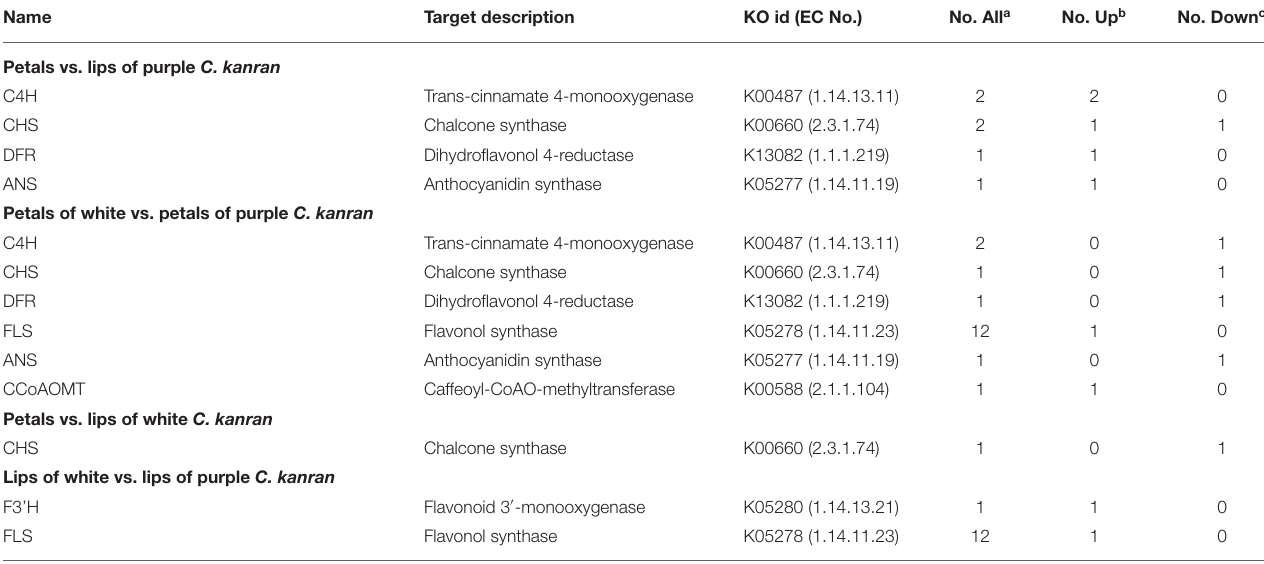
TABLE 2 | Shifts in the expression levels of candidate genes related to flower pigmentation.